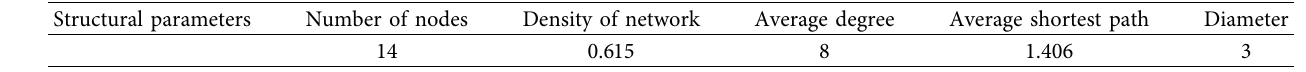
Figure 1: Network topology diagram of the vulnerability influencing factors in government procurement of elderly care services. Table 6: Statistical characteristics of Figure 1.